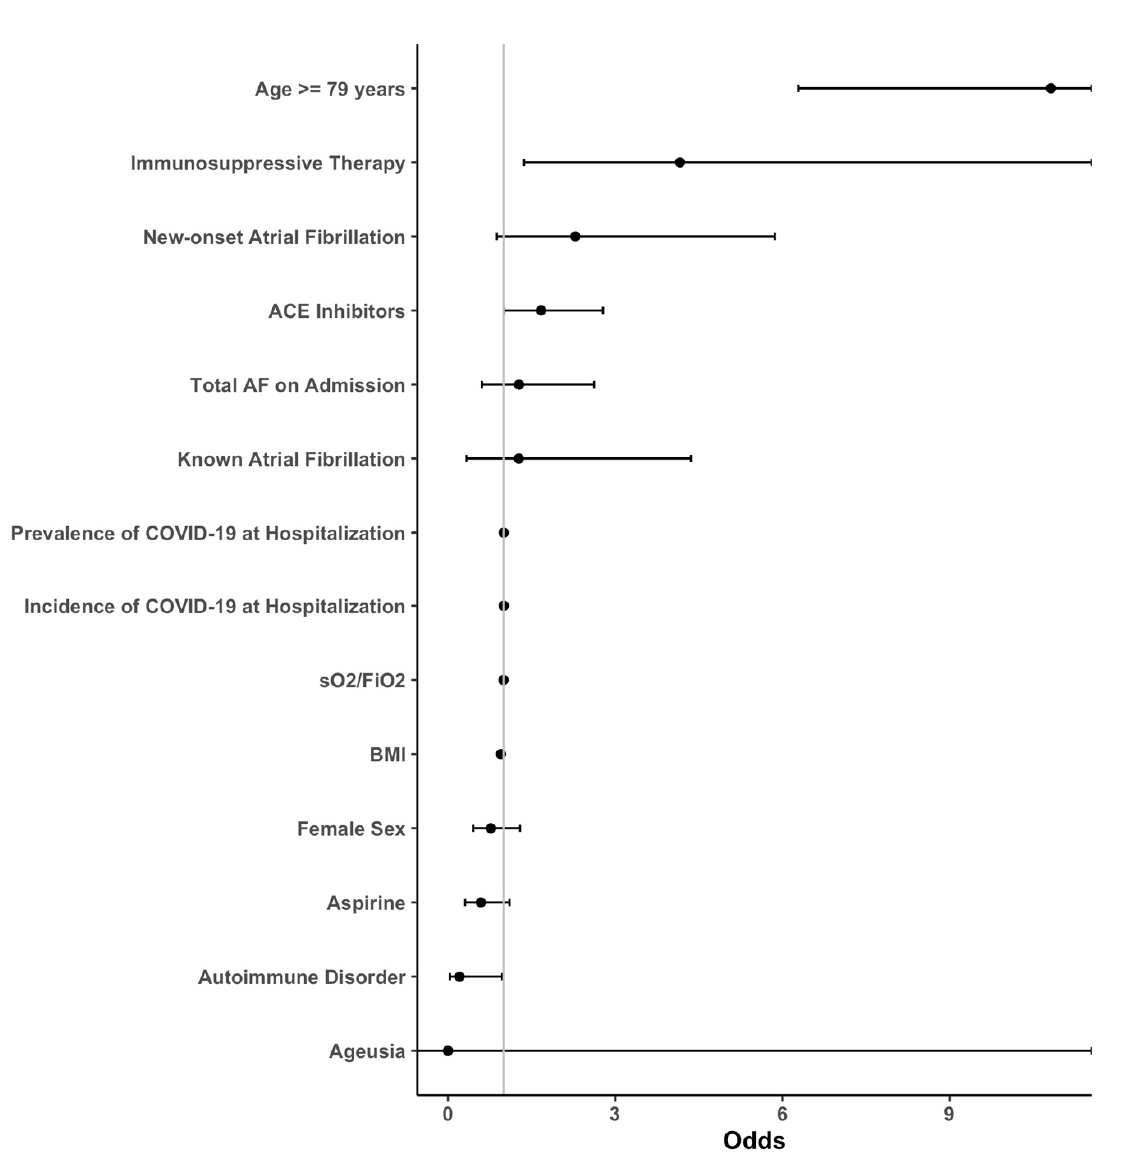
Figure 4. Forest plots of the secondary outcome “Long-Term Mortality”. The transfer risk for long- term mortality was assessed by sequential logistic models with a stepwise reduction based on the Aikake information criterion. Abbreviations: ACE = angiotensin-converting enzyme; AF = atrial fibrillation; BMI = body mass index; sO 2 = oxygen saturation; FiO 2 = fraction of inspired oxygen; COVID-19 = coronavirus disease 2019.